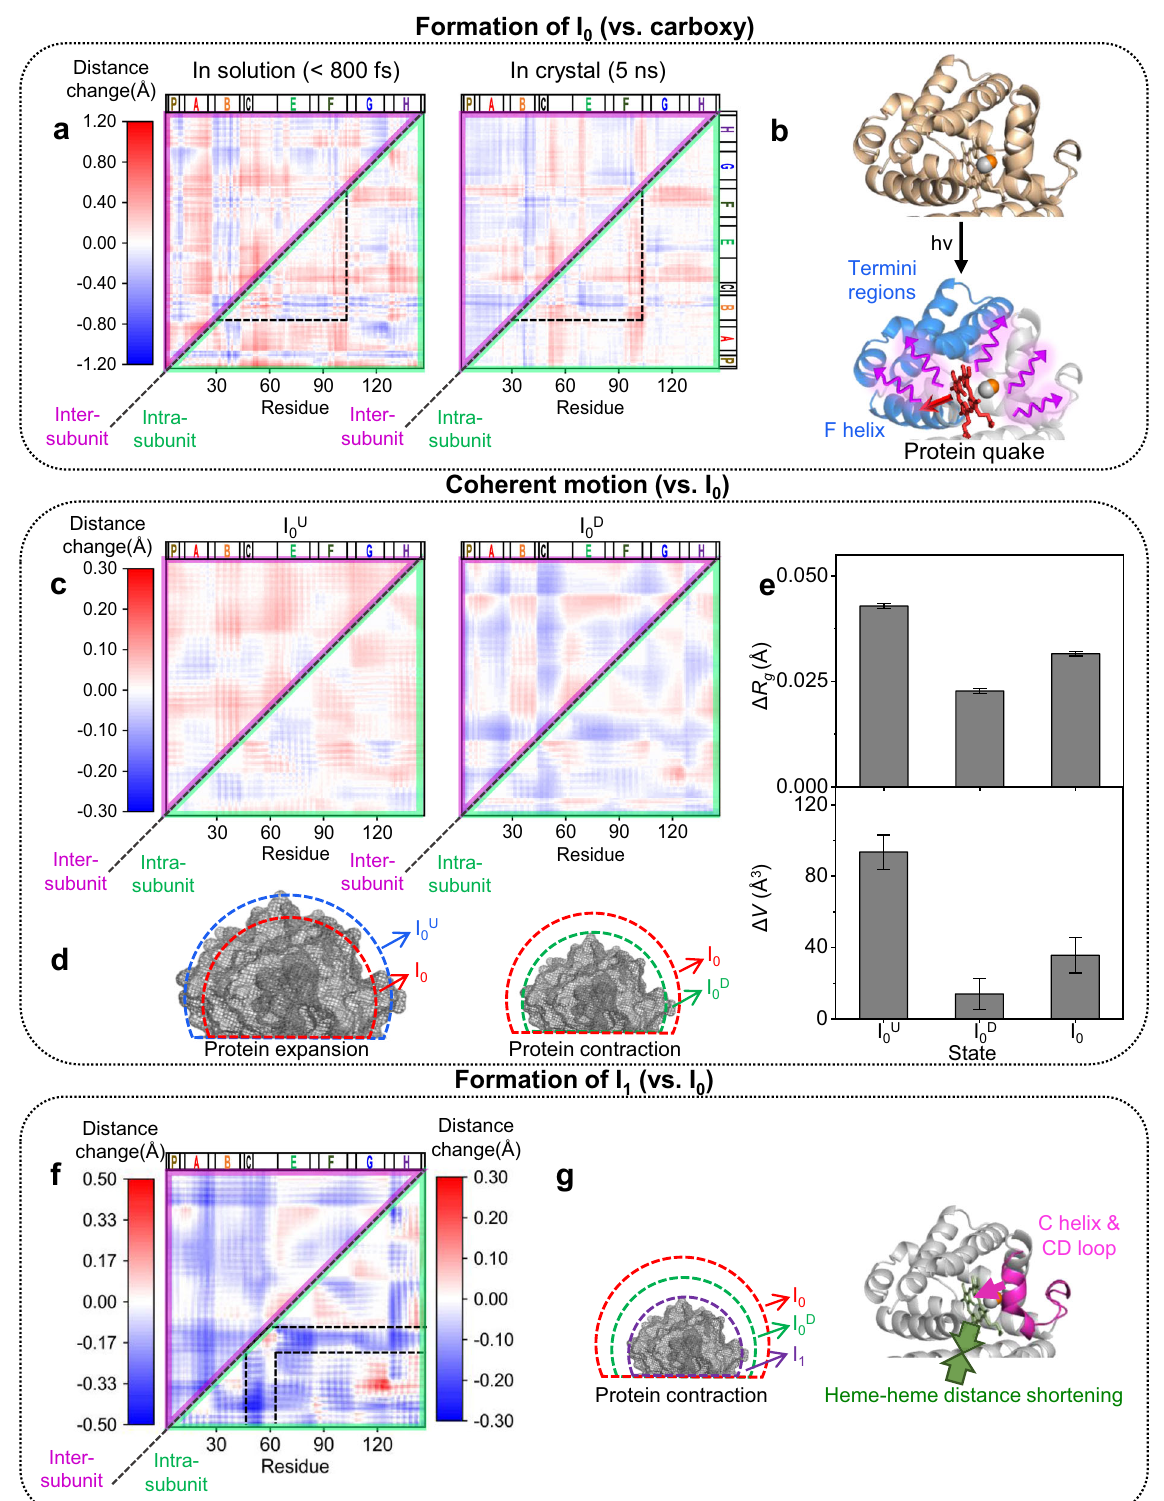
helix show a small Pearson correlation coef fi cient of 0.24, which indicates that N- and C-terminus regions show different movement in the solution and crystalline phase. The overall intra-subunit distance differences of the residues nearby N- and C-terminus regions are larger in I 0 than in the crystal. This feature can be rationalized by the fact that the movements of such residues are less constrained in solution. The inter-subunit DDMs of I 0 and